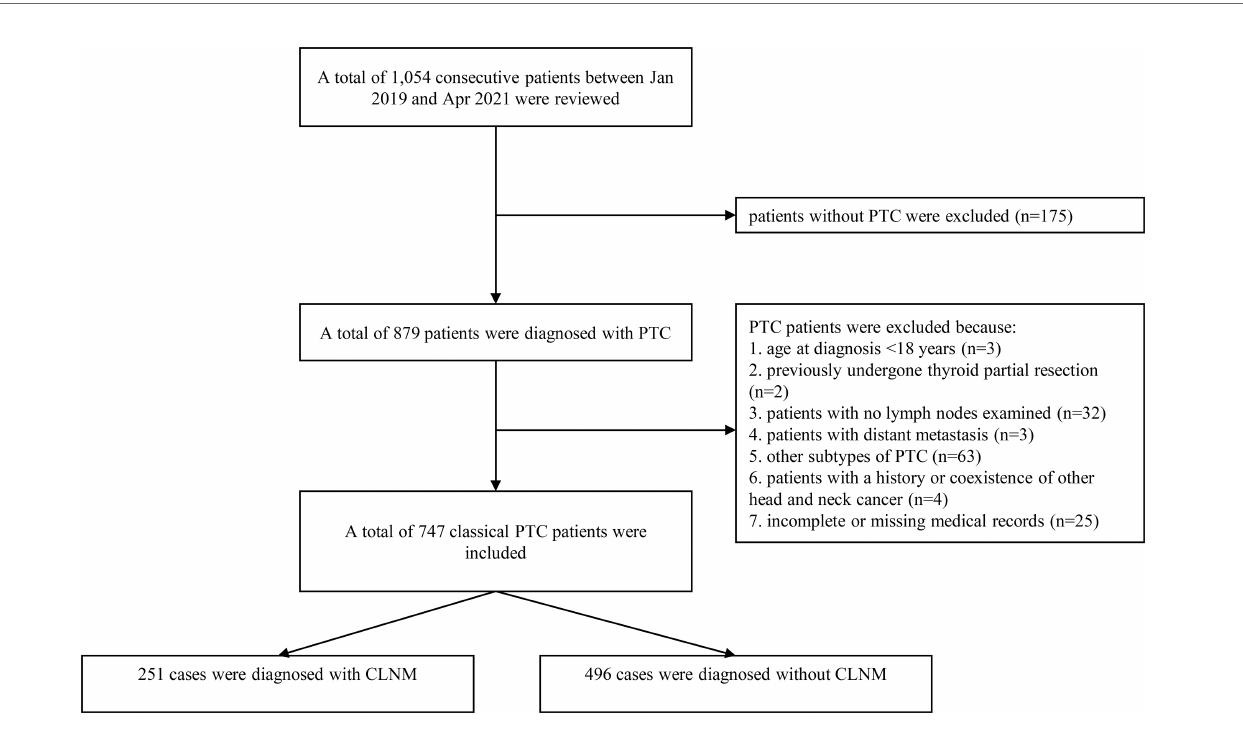
FIGURE 1 | The patients ’ selecting process in our